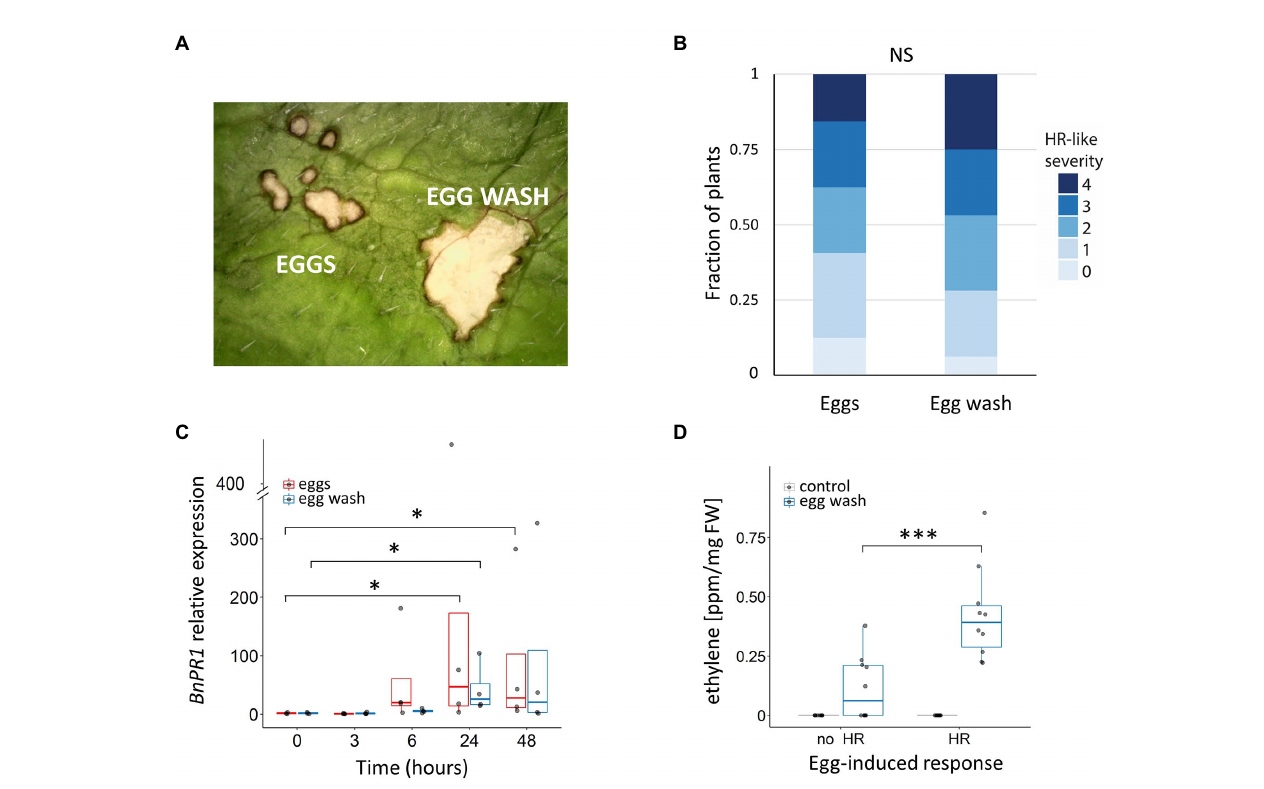
FIGURE 2 Plant responses induced by Pieris brassicae eggs and egg wash in Brassica nigra . (A) Picture of responses induced by eggs and egg wash next to each other on a leaf (microscopic image): both eggs and egg wash induce HR-like necrotic spots. (B) Quantification of severity of symptoms induced by egg wash and eggs. Shown is the fraction of plants that were scored in a specific class for each treatment ( N = 32 plants for both treatments; Kruskal–Wallis, p > 0.05). ns = no significant difference. (C) BnPR1 expression in plants after egg deposition (red box plots) or treatment with egg wash (blue box plots). Gene expression was measured by qRT-PCR and normalized to the housekeeping gene BnGADPH. Each treatment consisted of 3–4 biological replicates. Expression at each time point was compared to the 0 h timepoint (Kruskal–Wallis, p < 0.05 for eggs and p < 0.05 for egg wash). (D) Ethylene production in parts per million (ppm) by plants treated with egg wash. (Student’s T -test, p < 0.001). Each treatment consisted of 10 biological replicates. The height of the boxes in C-D represents the first to the third quartile of the range; the horizontal line within the box is the median; the whiskers indicate the data minimum and maximum; and dots represent data points. Asterisk indicates p < 0.05, ***